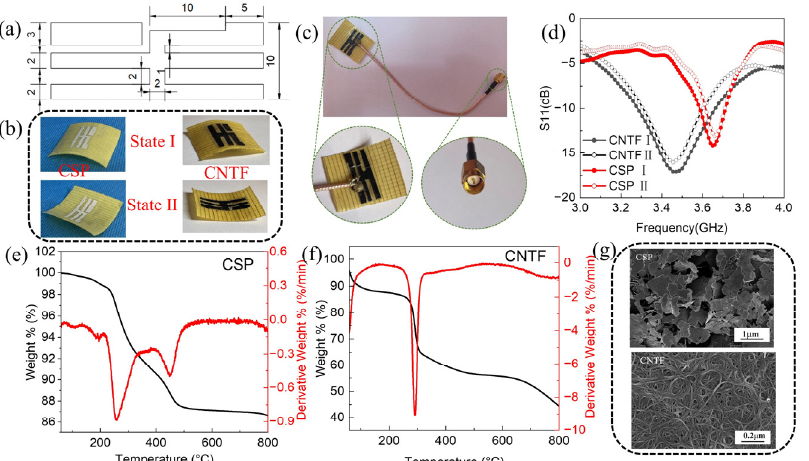
Figure 3. ( a ) Digital image of the geometry and size of as-fabricated reconfigurable antennas. ( b ) The physical images of the CSP-based and CNTF-based bi-stable antennas in state I and state II, respectively. ( c ) Physical diagram of the CNTF-based bi-stable antenna with a coaxial line feed. ( d ) Reflection coefficient (S11) of bi-stable antennas with different radiation layer materials in two states. ( e ) TG curves of conductive silver paste. ( f ) TG curves of carbon nanotube film. ( g ) SEM image of the radiation layer material.